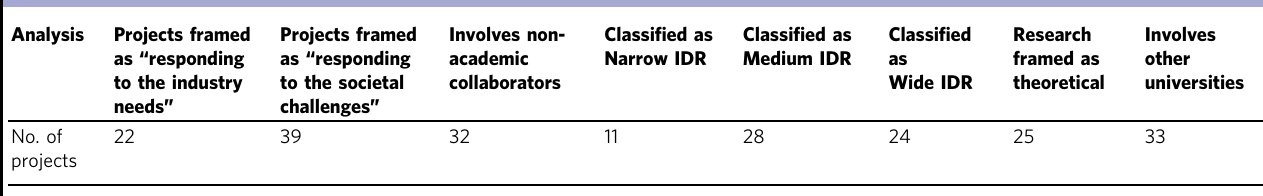
Table 4 Summarised content analysis of the recent 63 projects at BRL; analysis of collaborations, framings and interdisciplinarity